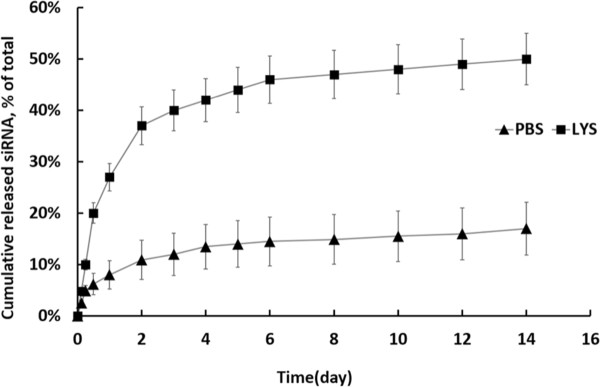
Cumulative release profile of siRNA from chitosan hydrogel/siRNA. The formulated hydrogel was degraded either in PBS alone (marked as PBS) or PBS contained lysozyme (marked as LYS). Fluorescence intensity was measured for samples collected from various time points and background level from blank well was subtracted. The accumulative release profiles were calculated based on concentrations obtained. Data was presented as mean ± SD (n = 3).